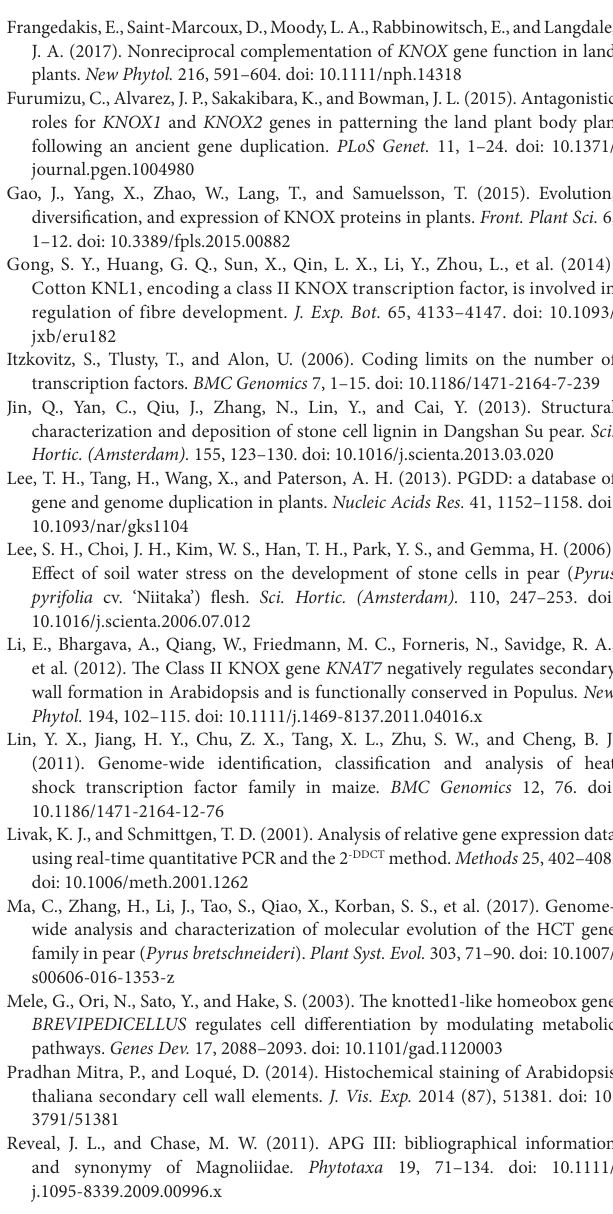
SUPPLEMENTARY TABLE 4 | Ka/Ks analysis for KNOX duplicated genes of pear. SUPPLEMENTARY TABLE 5 | List of KNOX protein sequences of four rosids. SUPPLEMENTARY TABLE 6 | Collinearities were identified in four rosids. SUPPLEMENTARY TABLE 7 | Putative cis -acting regulatory elements in the PbKNOX promoters. SUPPLEMENTARY TABLE 8 | Sequence identity and similarity among PbKNOXs and KNOX protein sequences of various plants. SUPPLEMENTARY TABLE 9 | Potential KNOX binding sites in pear lignin